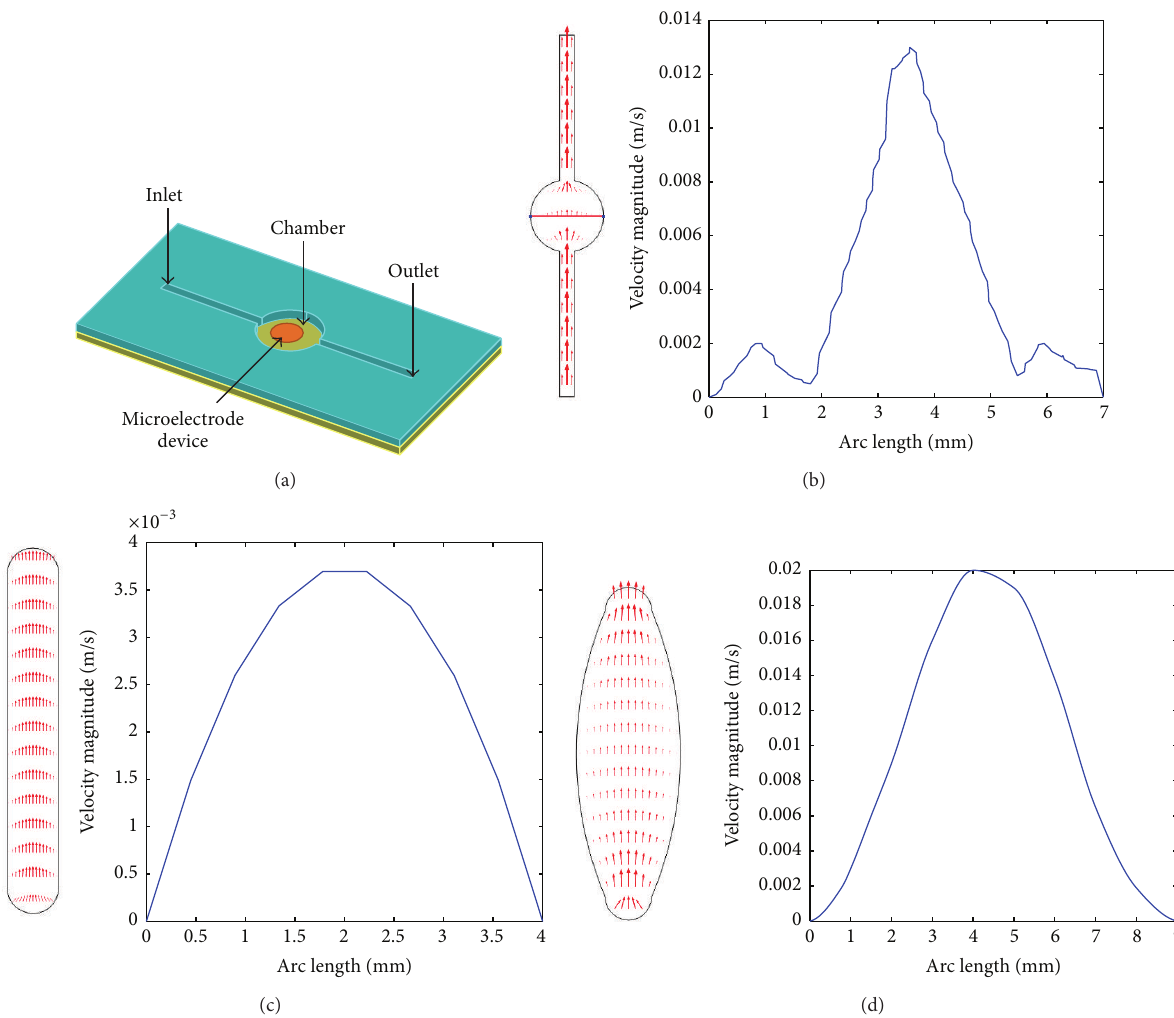
Figure 1: A typical benchtop-fabricated microfluidic channel’s (a) components with various gasket design velocity profile as shown in (b), (c), and (d). Arc length refers to the channel length in the middle axis as represented by the red line in